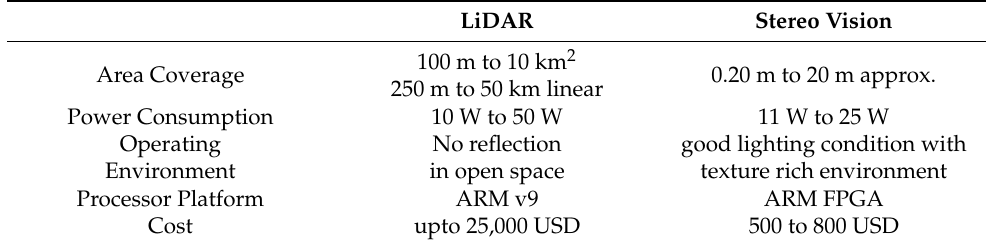
Table 1. Sensor comparison.